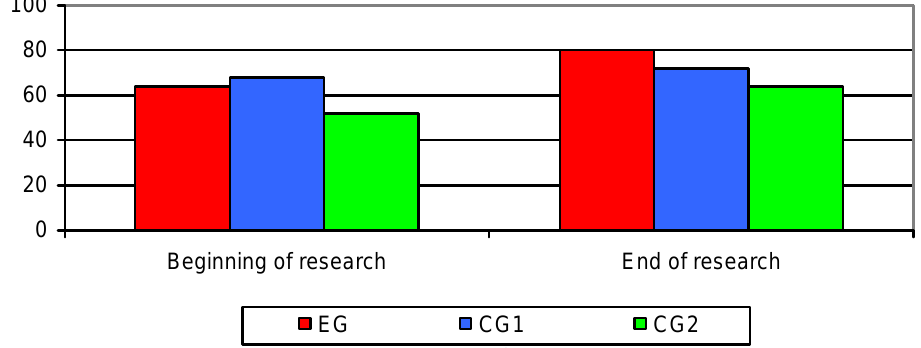
Fig.2 Comparative characteristics of operative (image) memory indicators during